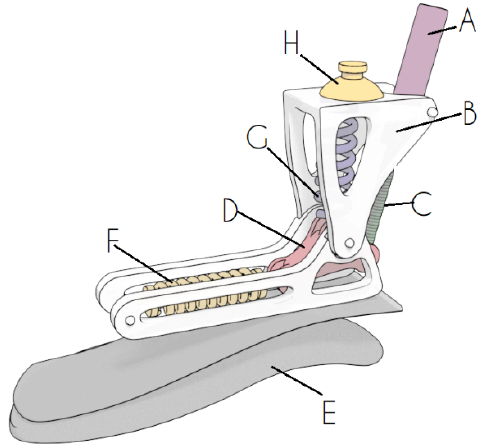
Figure 11. MAP active ankle–foot prosthesis.